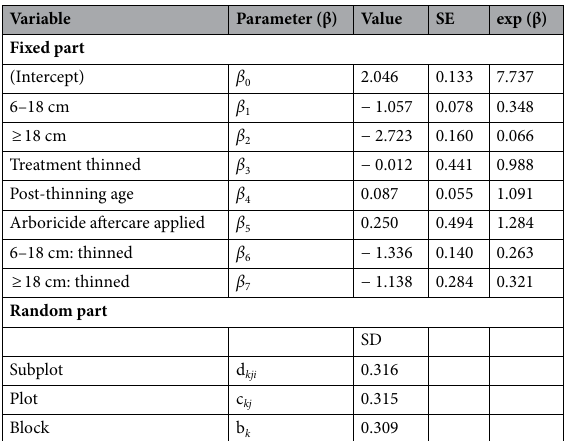
Table 6. Generalized linear mixed-effects model (GLMM) showing the effects of fixed factors (treatment, post-thinning age, and arboricide aftercare) on the abundance of encroaching trees/shrubs measured in stem classes, 0–6, 6–18 and ≥ 18